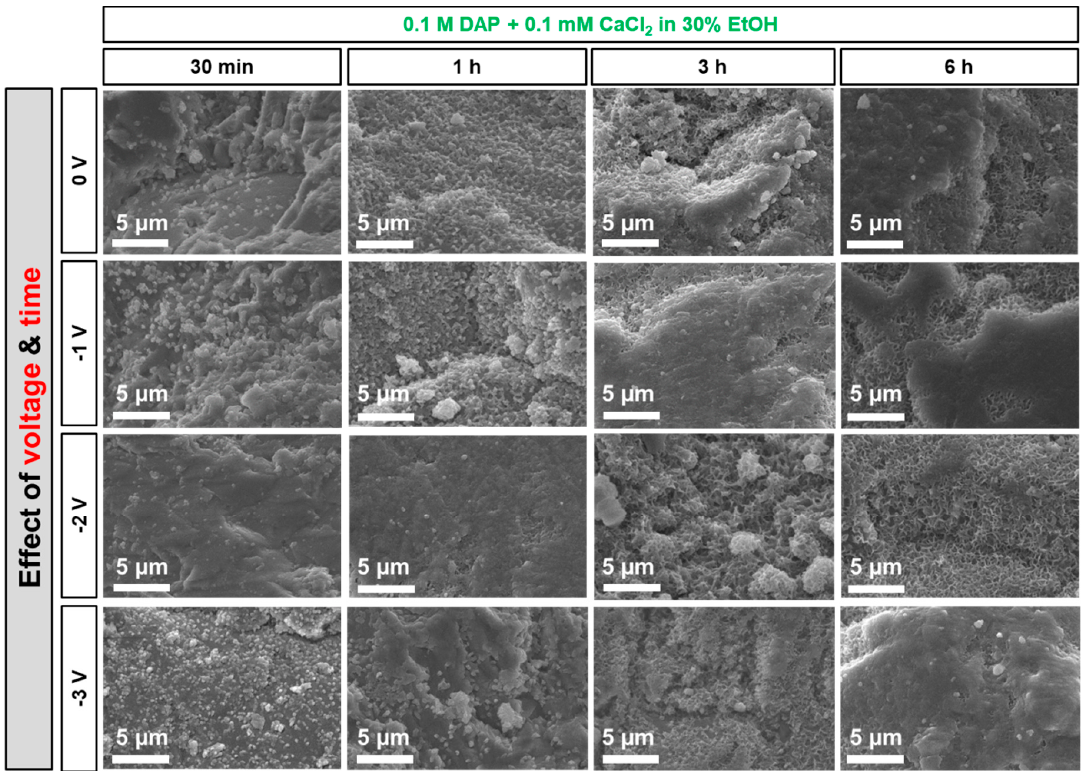
Figure 9. Effect of voltage and time on the morphology of the new CaP phases formed from the less-concentrated solution (0.1 M DAP + 0.1 mM CaCl 2 in 30 vol.% EtOH).